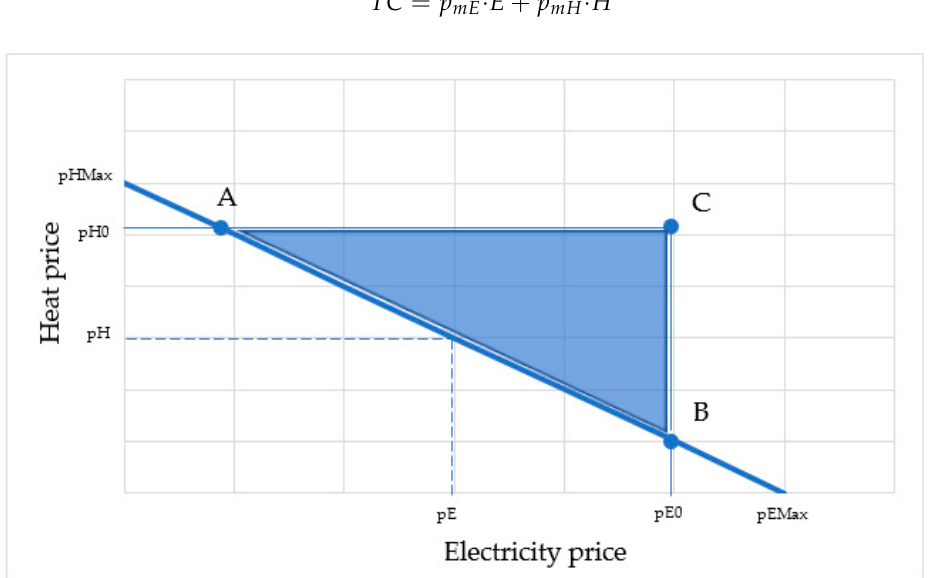
Figure 2. Setting prices for electricity and heat generated in cogeneration. The line AB in Figure 2 indicates the pairs of p E and p H values which, for the